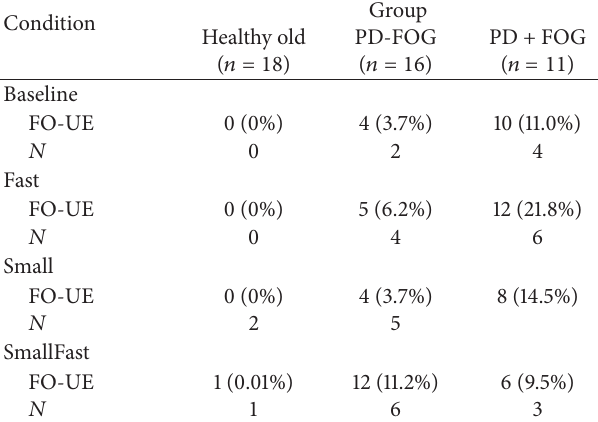
Table 2: Number of FO-UE episodes. Table 3: Spearman’s correlations between UE PCI, Gait PCI, FOG- Q, and number of FO-UE